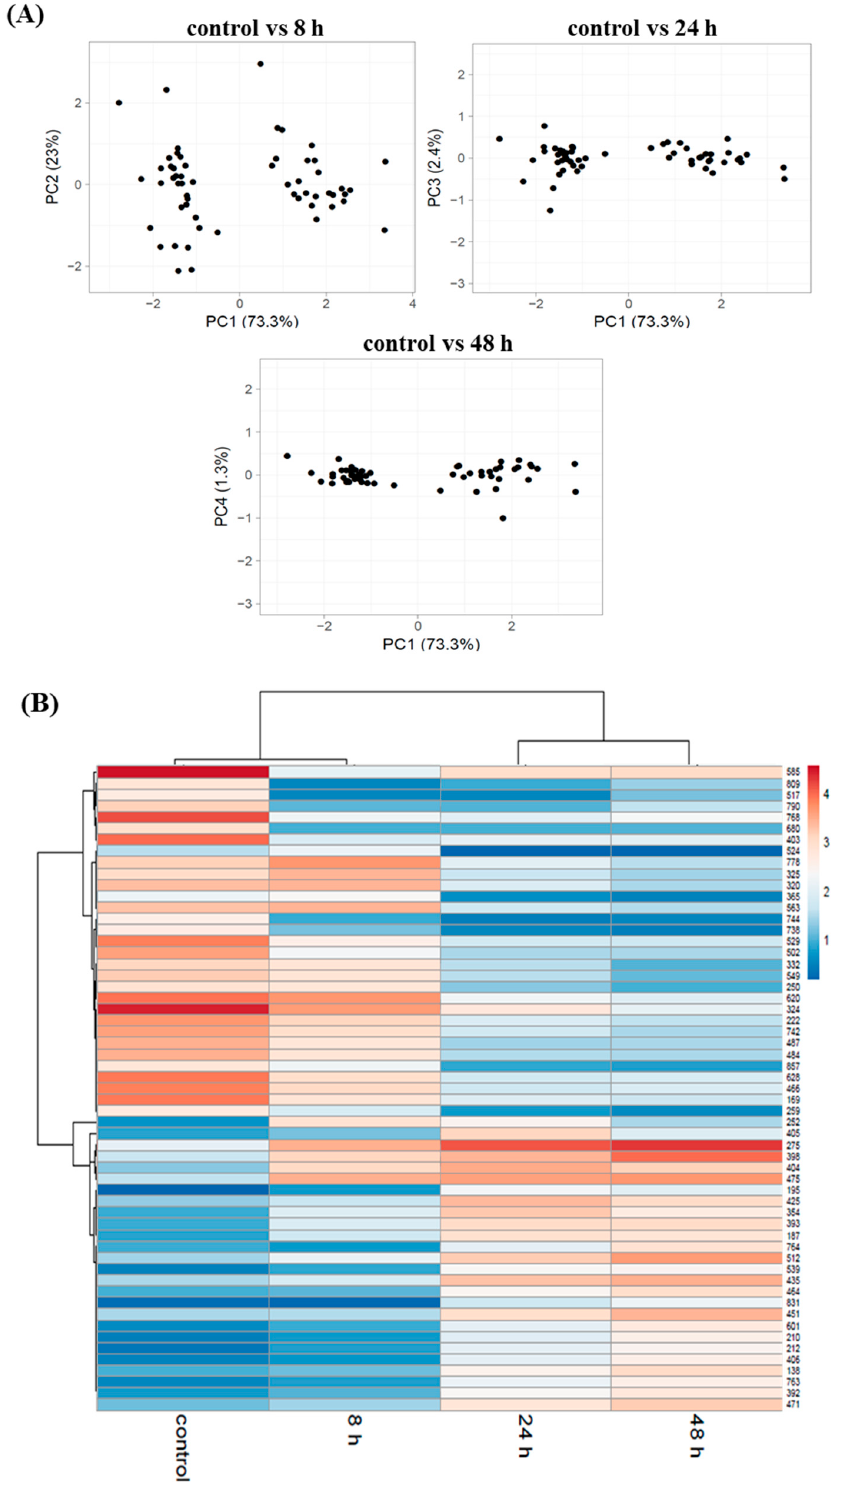
Figure 4. Protein abundance analysis in Pseudomonas putida KT2440 during mcl-PHAs synthesis. ( A ) PCA plots of the 2D-DIGE proteomics profile at 8 h, 24 h, and 48 h of the bioprocess compared to the control. ( B ) Cluster analysis of the normalized proteins spots abundance that were differentially regulated at 8 h of the non-limited cultivation (treated as a control) and at 8 h, 24 h, and 48 h of the growth under nitrogen-limited conditions. The cluster analysis resulted in a dendrogram indicated on the left of the heatmap. Every horizontal line indicates one protein spot.